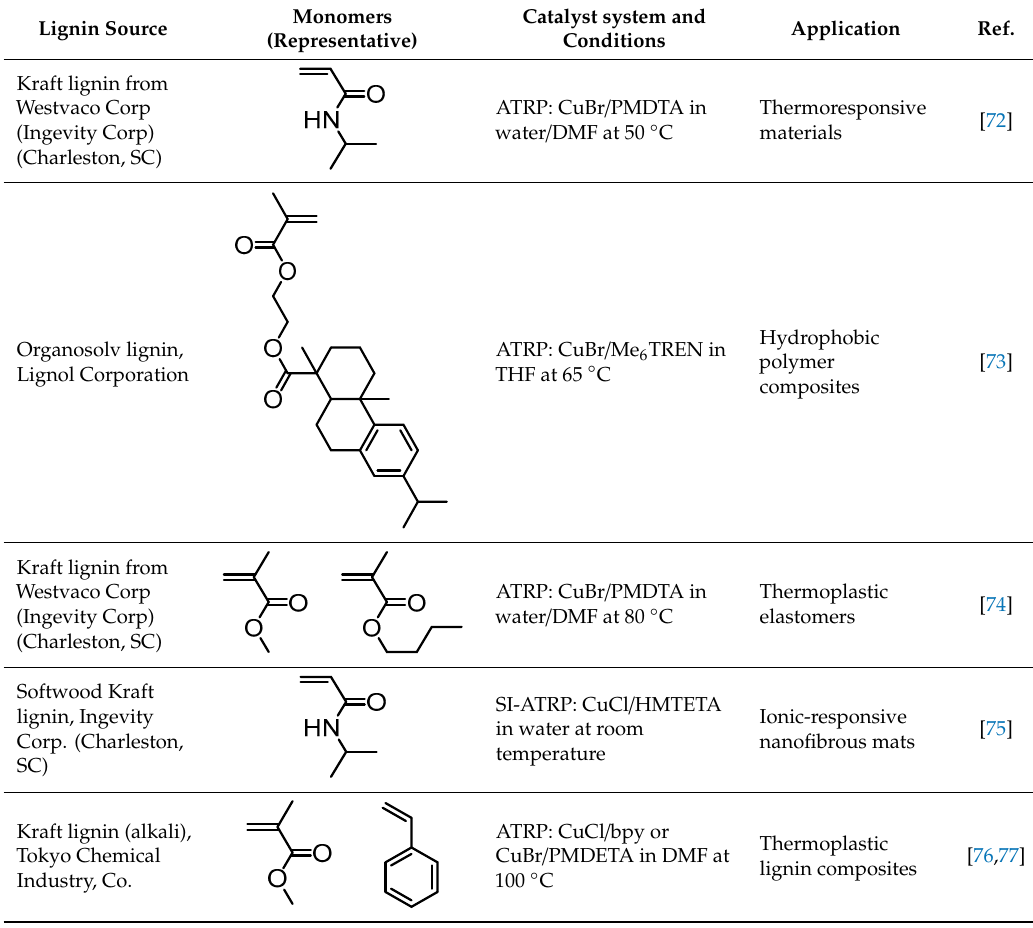
Table 2. Summary of recent literature on ATRP modifications of lignin.